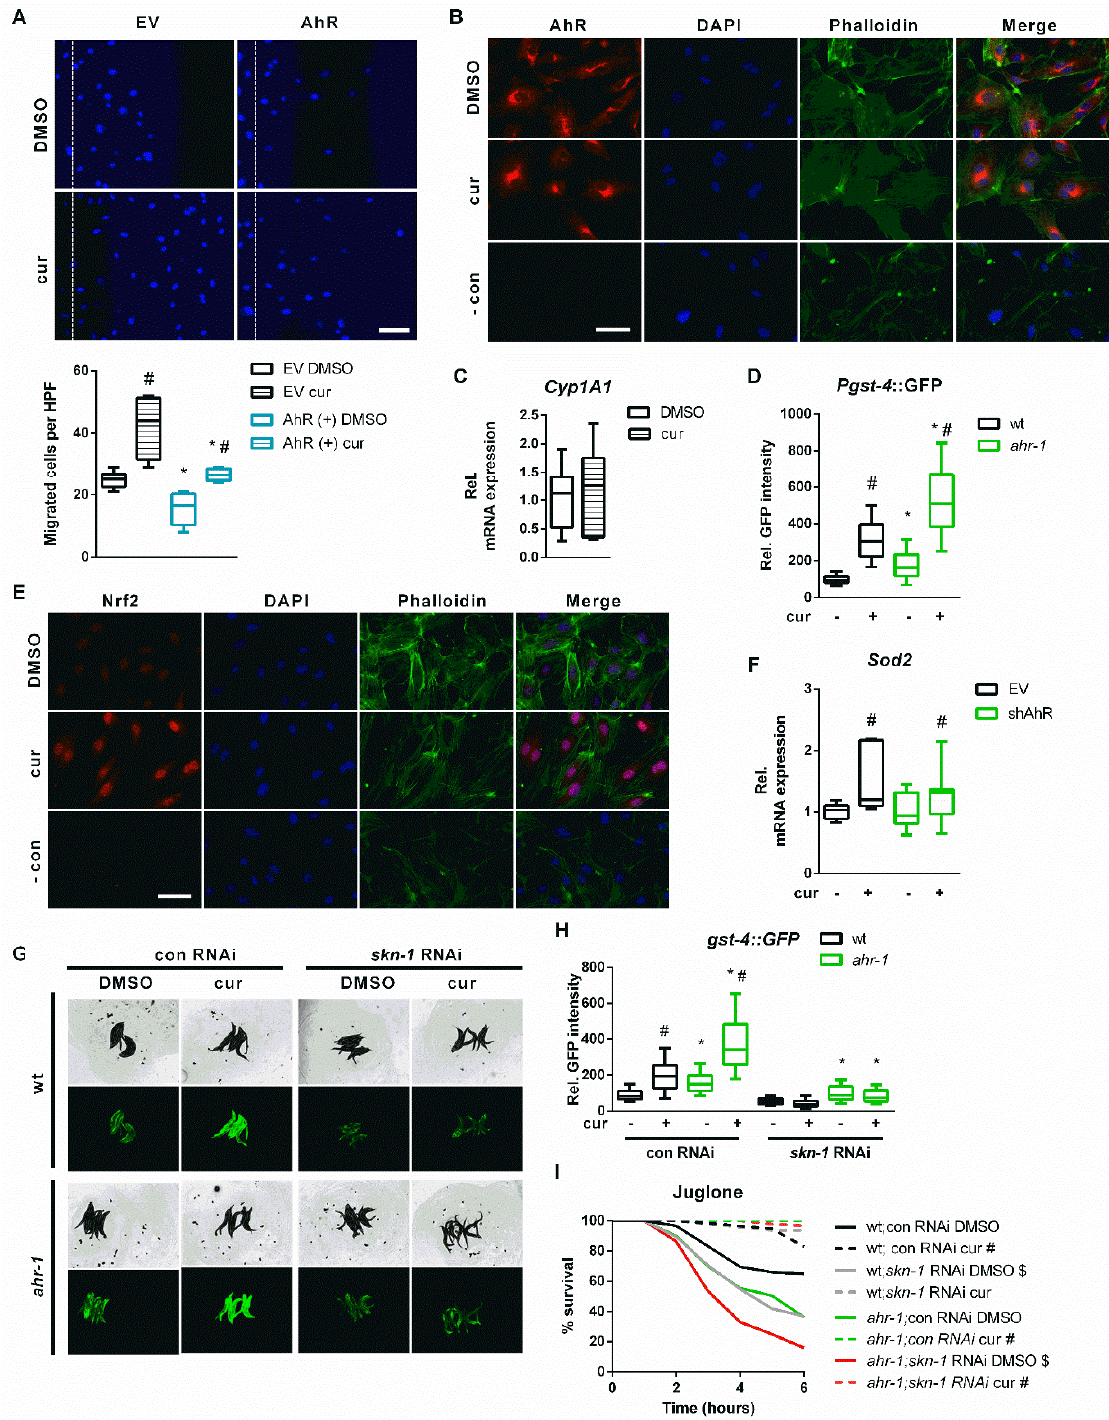
Figure 5. Curcumin activates Nrf2/SKN-1 independent of the AhR. ( A ) Scratch wound assay in curcumin (cur)- or DMSO-treated human primary EC transfected with an empty vector (EV) or an expression vector for human AhR. Upper panel: representative pictures; the dashed line represents migration start. Scale bar: 100 µm. Lower panel: quantification; boxplots show data of 4–6 experiments. Statistical test: 1-way ANOVA, * p < 0.05 vs. EV, # p < 0.05 vs. DMSO. ( B , C ) Human primary EC were treated with cur or DMSO. ( B ) Representative immunostainings: AhR is stained in red, nuclei were visualized with DAPI (blue), the cytoskeleton is counterstained with phalloidin (green), merge shows an overlay of all fluorescence channels. In the negative control (- con), the first antibody was omitted, and cells were stained with Alexa 488-coupled phalloidin and DAPI. Scale bar: 50 µm. ( C ) Relative cyp1a1 expression was assessed by qPCR. Mean expression in the DMSO-treated